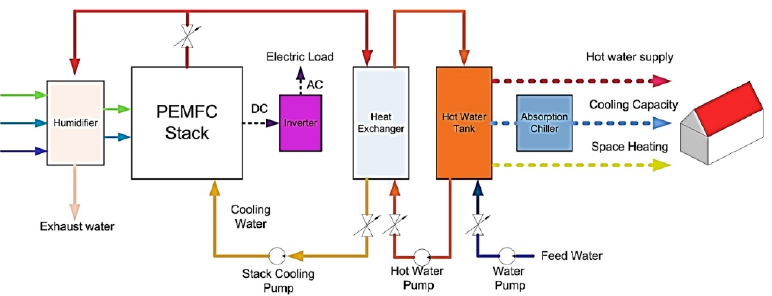
Figure 3. Proton exchange membrane fuel cell absorption chiller [26]. Republished with permission from Elsevier (License no: 5416380834293).